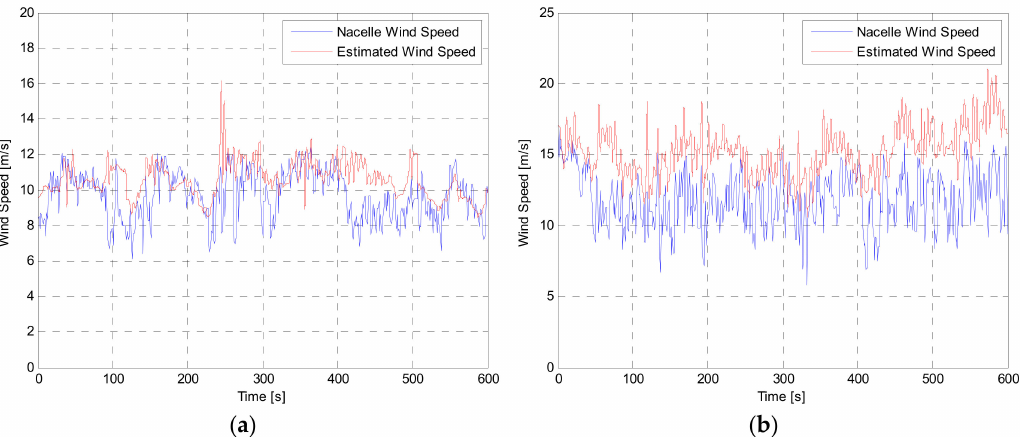
Figure 13. Comparison between actual nacelle wind speed and estimated wind speed: ( a ) transition region; ( b ) rated power